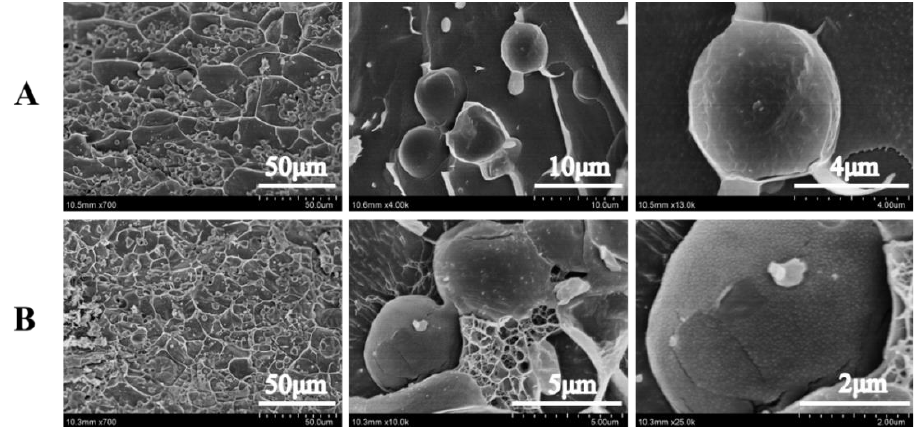
Figure 4. Cryo-SEM images of Pickering emulsion gels with different concentrations of kC (( A ) 1%, ( B ) 2%) at 1% XG/Ly NPs.